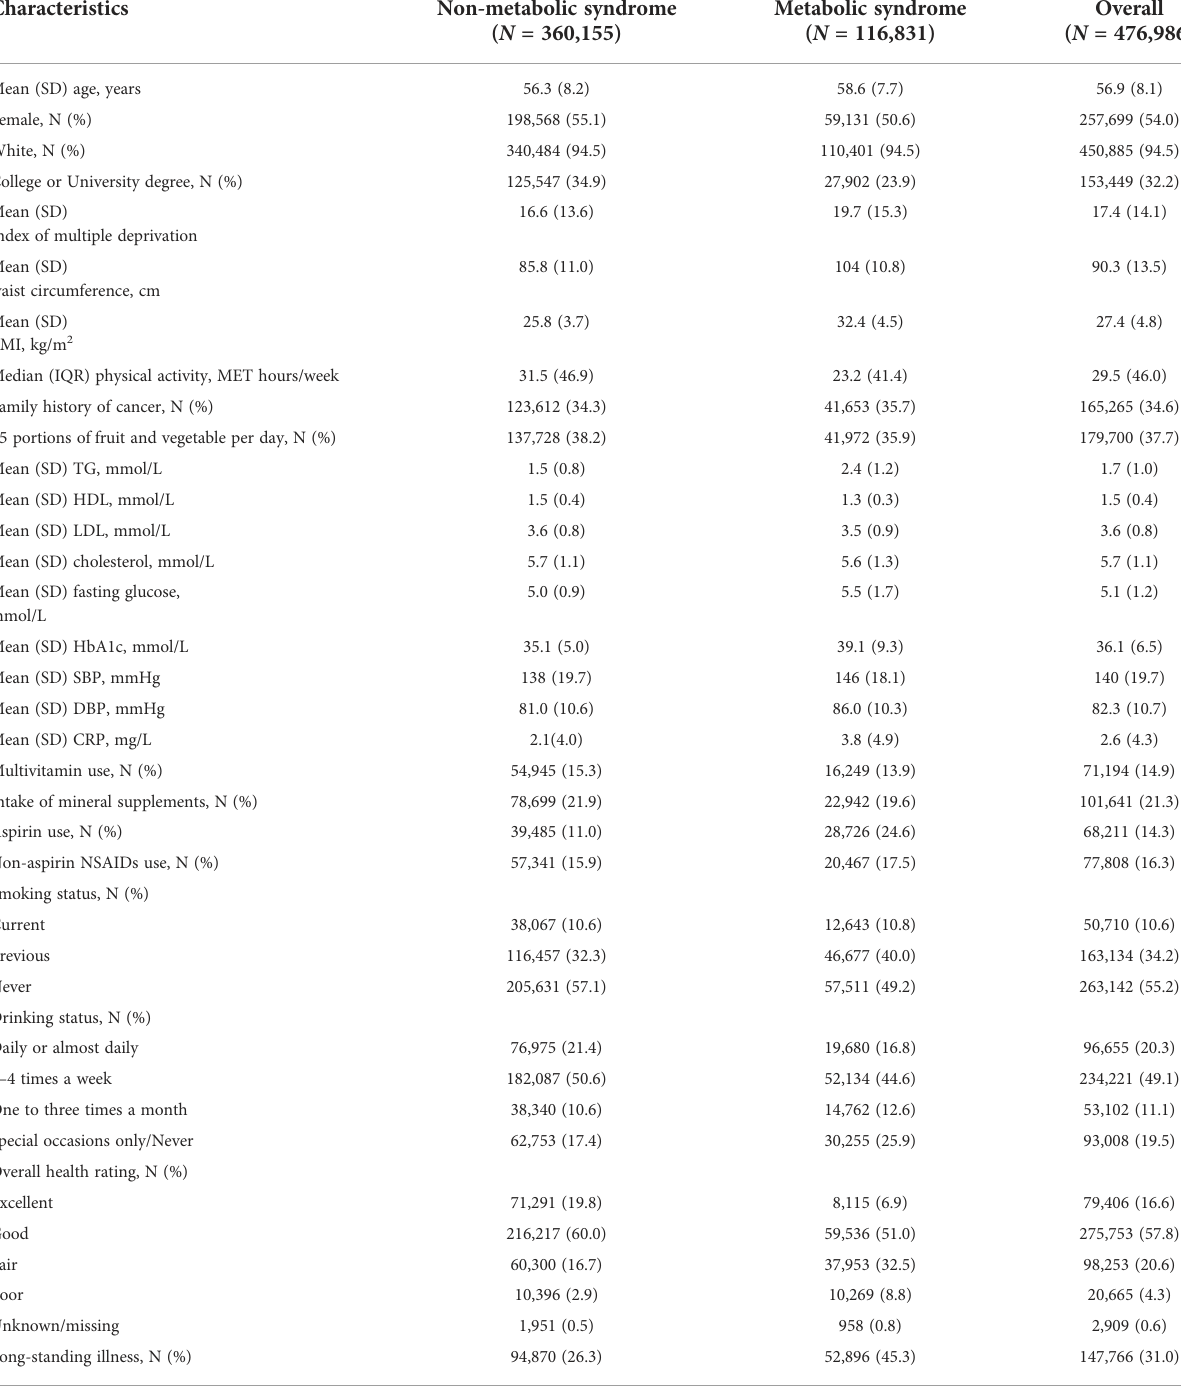
TABLE 1 Baseline